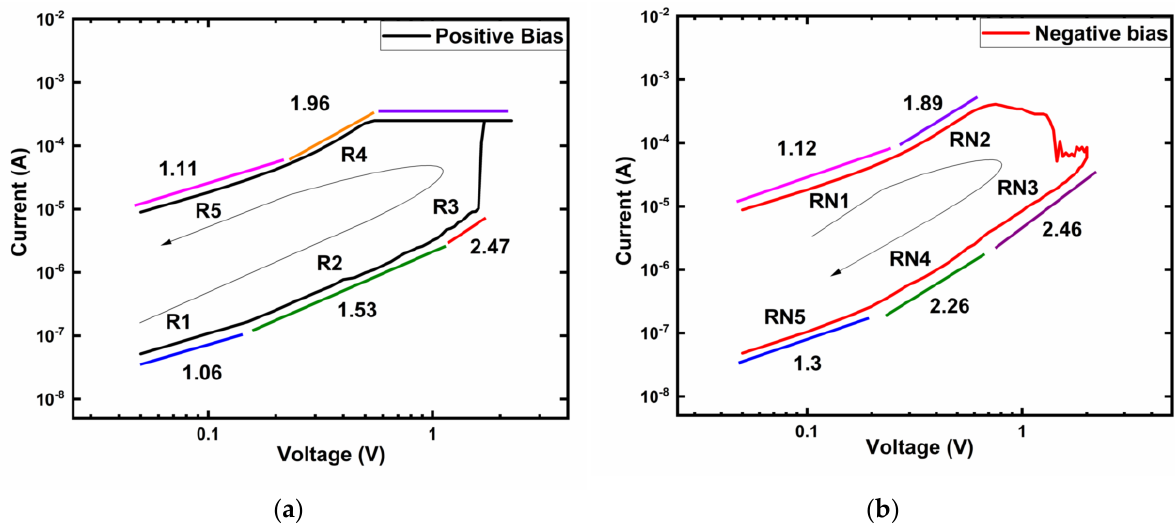
Figure 5. Log (I) − log (V) characteristics of Ti/MgF x /Pt memory devices with I cc = 250 μ A. ( a ) Positive bias voltage region; ( b ) Negative bias voltage region with slopes of different parts.